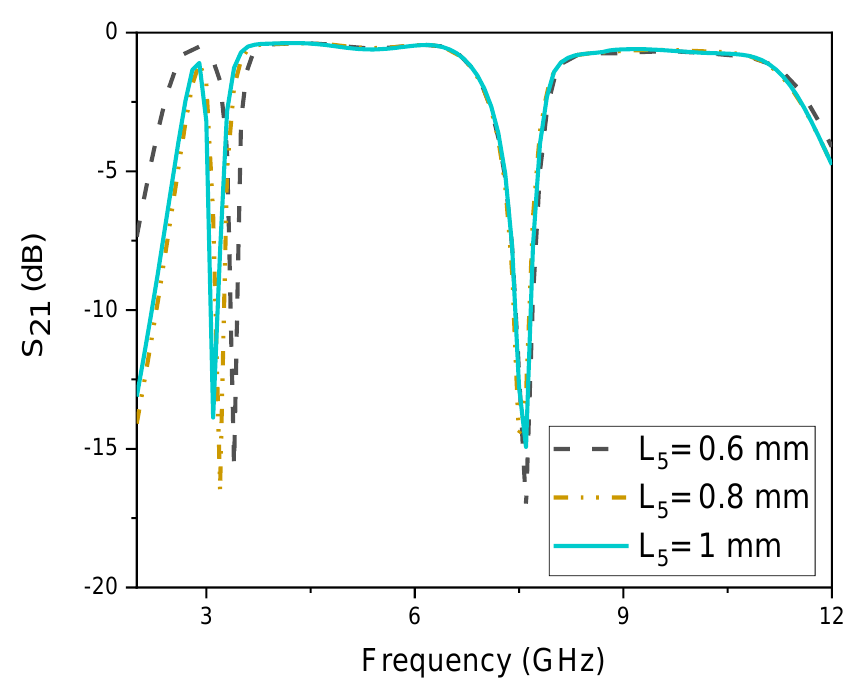
Figure 13. S 21 plot of first band control with parameter W 6 .